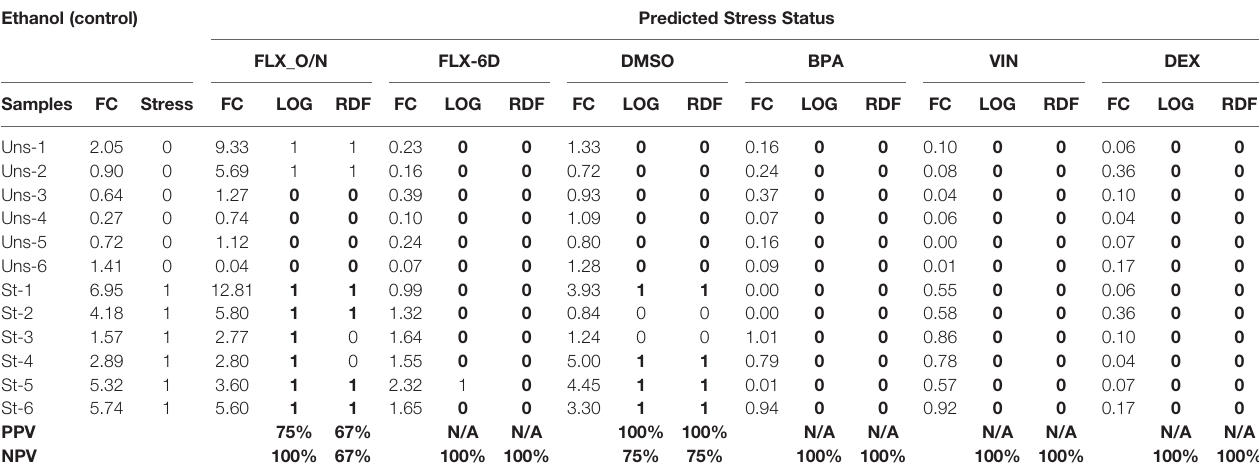
TABLE 1 | Prediction of stress response based on the whole-body eGFP mRNA levels using regression random forest (RDF) and logistic regression (LOG) model trained by ethanol (control) group. Ethanol